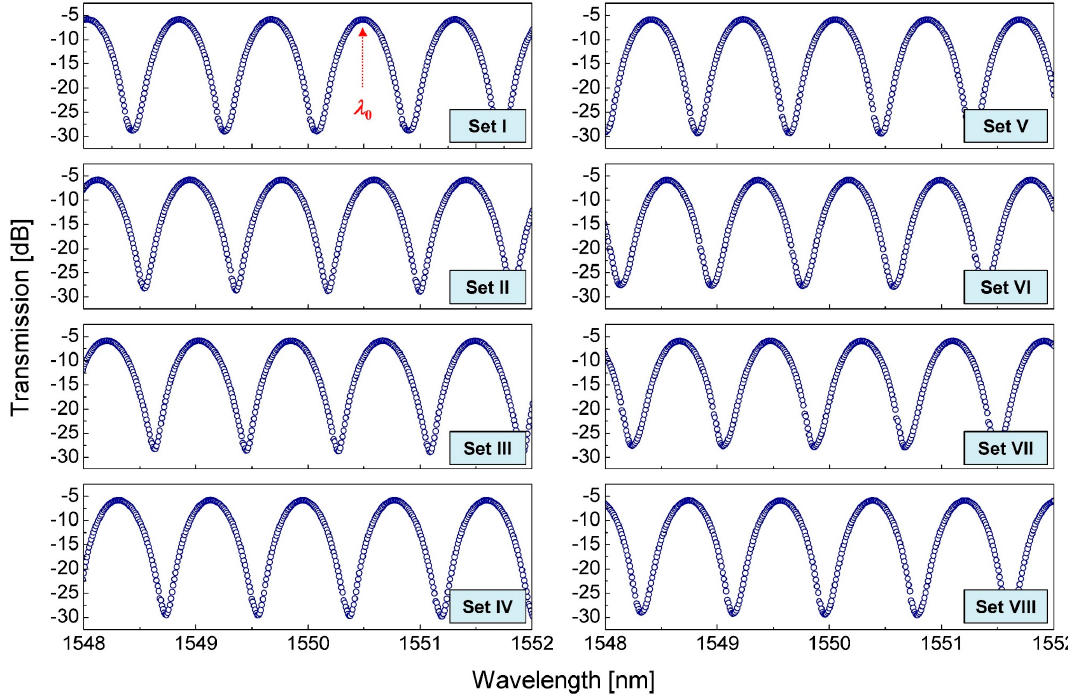
Figure 5. Narrowband transmission spectra, measured at the eight FAOA sets (sets I to VIII) shown in Table 1. Table 1. Eight selected sets of FAOA’s for wavelength tuning of the constructed filter. Set